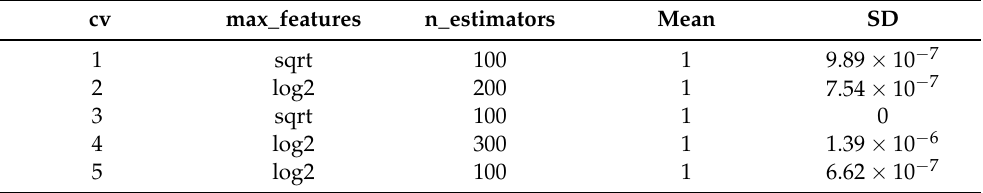
Table 7. Best random forest model by